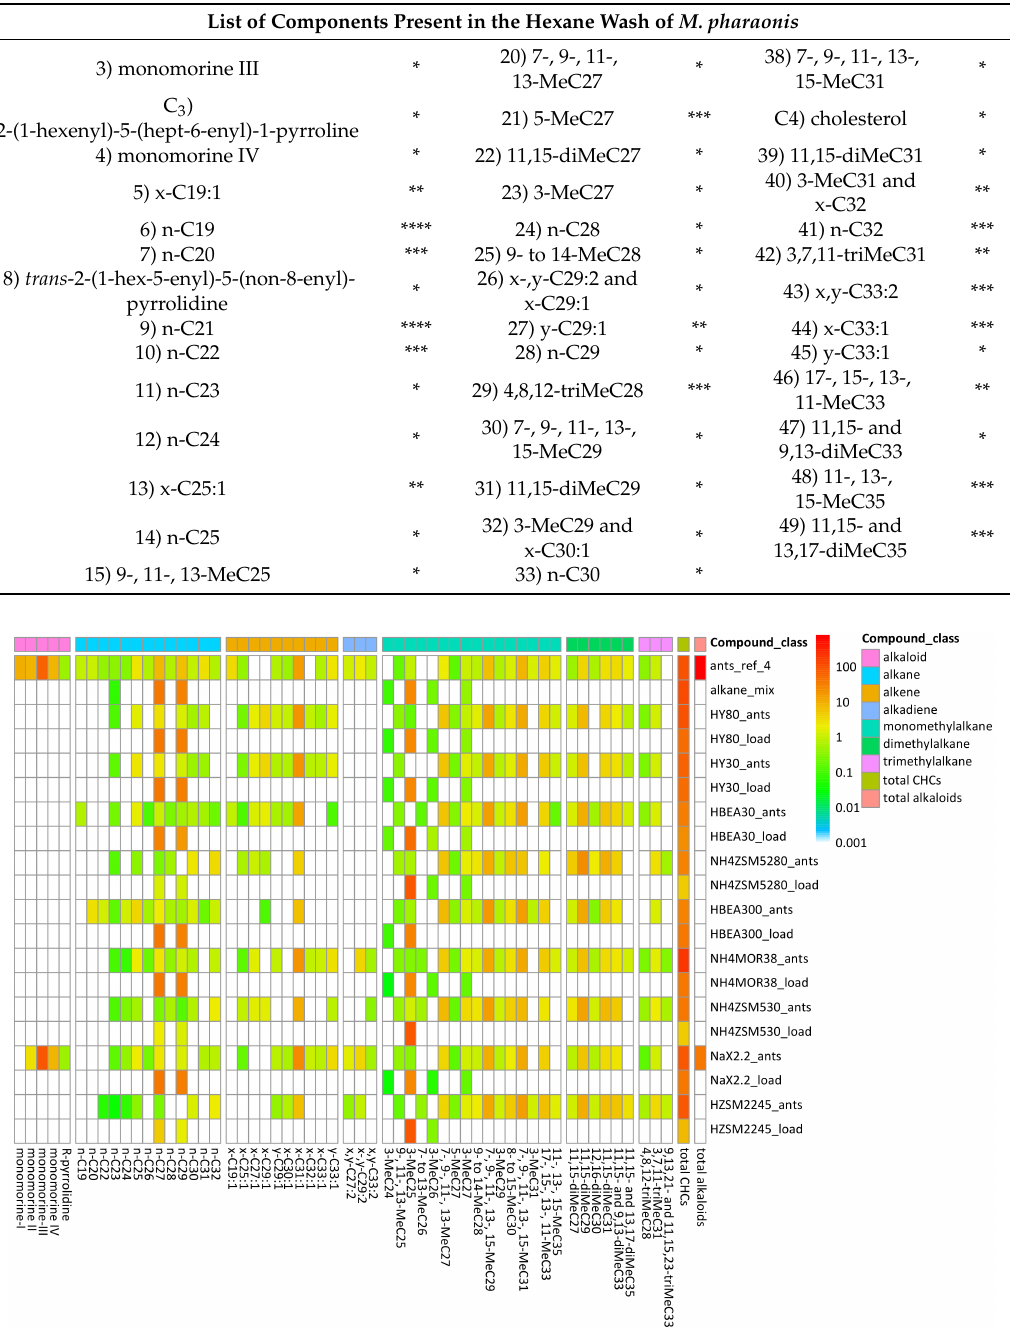
Figure 2. Heat map of the GC-MS data, showing the extracted cuticular profile composition (percent CHC (cuticular hydrocarbons, without alkaloids) and percent alkaloid) of M. pharaonis foragers and the adsorption of the different epicuticular compounds by nine zeolite materials upon exposure to foragers for 1 h (represented as _ant). The composition of the alkane mixture (alkane_mix) and the compounds retrieved from the zeolites after loading them with the solution (represented as _load) are also provided. Materials are sorted by induced mortality, from high at the top to low at the bottom [21]. When two compounds were present in the same peak, the most abundant compound was chosen for representation. R-pyrrolidine is trans -2-(1-hex-5-enyl)-5-(non-8-enyl)-pyrrolidine and total CHC is total cuticular hydrocarbons. Total CHC and total alkaloid are represented in µ g/500 µ